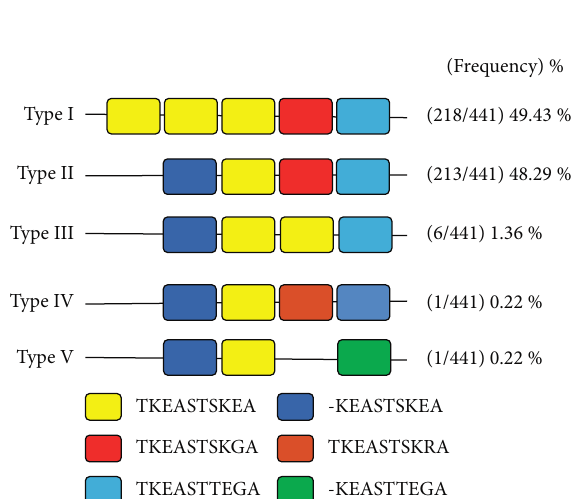
Figure 1: Repeat types (I–V) observed within C-terminal PfKHARP clinical isolates from Saudi Arabia and their frequency. Each deca and nonapeptide motifs observed within 441 sequences is color